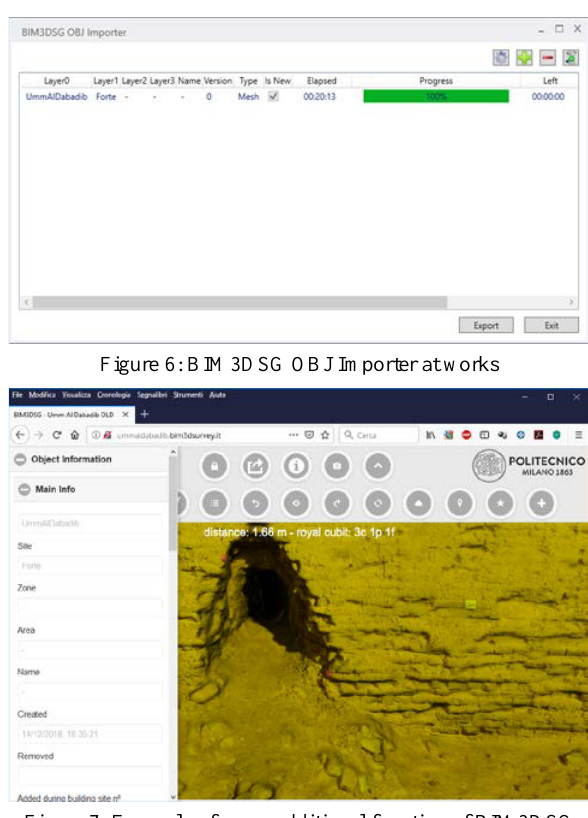
Figure 7: Example of some additional function of